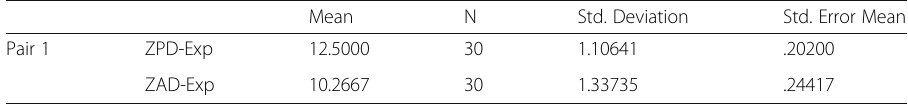
Table 13 Descriptive Statistics of the ZPD and ZAD of the Experimental Group on the Posttest Mean N Std. Deviation Std. Error Mean Pair 1